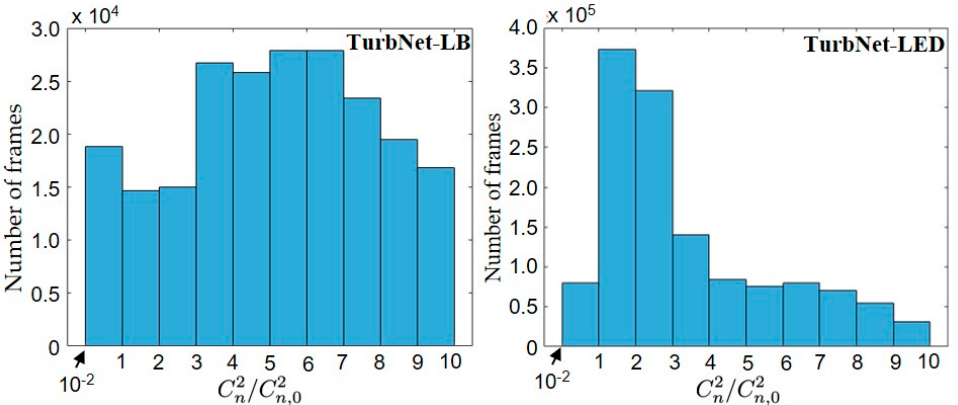
Figure 5. Distribution of scintillation frames in the TurbNet-LB ( left ) and TurbNet-LED ( right ) datasets obtained under different turbulence conditions ( C 2